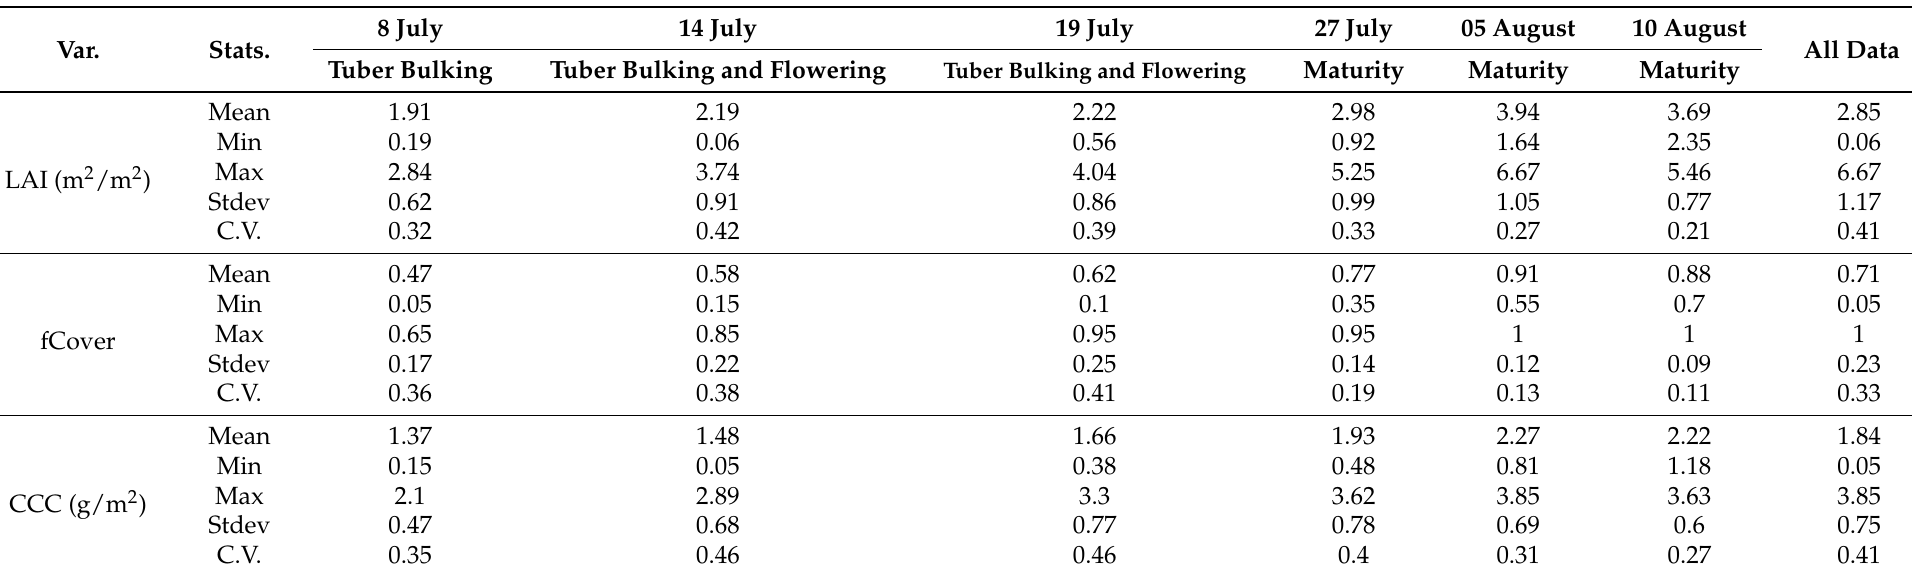
Table 4. Descriptive statistics of the measured variables over six dates in 2016 for a potato